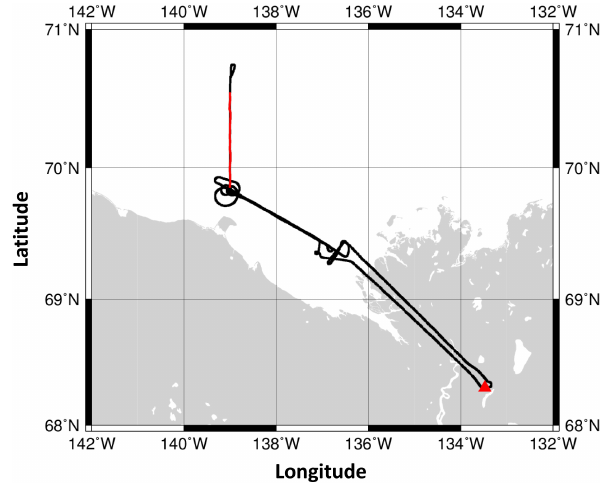
Figure 1. Track of Flight 11 as performed on 15 May 2012 in the Northwest Territories of Canada and the Beaufort Sea. The triangle marks Inuvik Mike Zubko Airport and the red line shows the region where the boundary layer cloud was